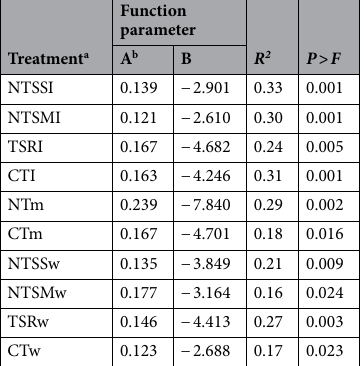
Table 2. Functions and related parameters for the liner relationship between soil CO 2 fluxes (F s ) and soil WFPS (W f ) at 0–30 cm depth in every cropping patterns: F s = A × W f + B. The data were adopted to fit into the function in 2014–2016. a The descriptions of the treatment codes are given in Table 4. b A and B are constants of the liner equation.